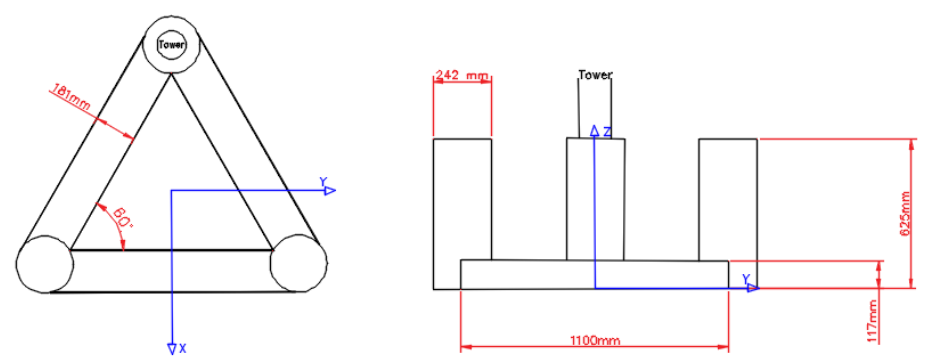
Figure 2. Layout and dimensions of the 1/60th scale